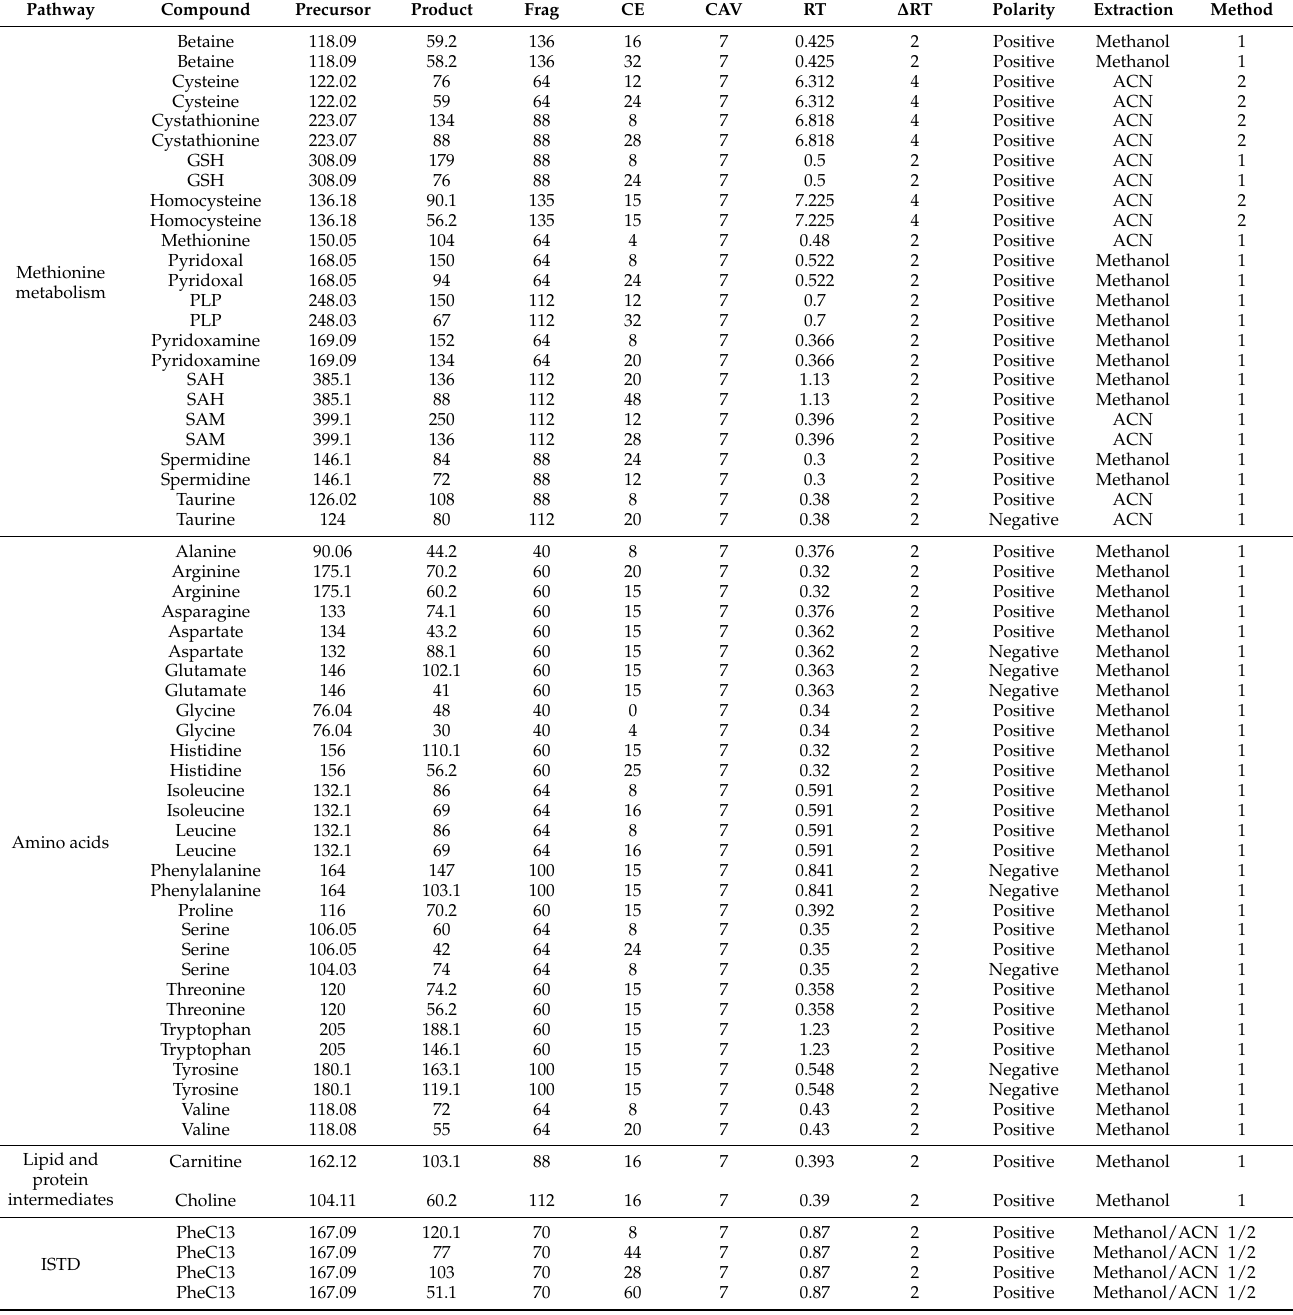
Table A3. Analytical traits of the metabolites measured in animal heart. Precursor ion (Precursor) and product ion (Product) are given as m / z . Fragmentor (Frag), collision energy (CE), and cell acceleration voltage (CAV) are given as voltage; retention time (RT) and retention time window ( ∆ RT) in minutes. Method 1 and 2 refer to metabolite extraction protocols (see material and methods for details). Glutathione (GSH); pyridoxal 5 (cid:48) phosphate (PLP); S-adenosylmethionine (SAM);